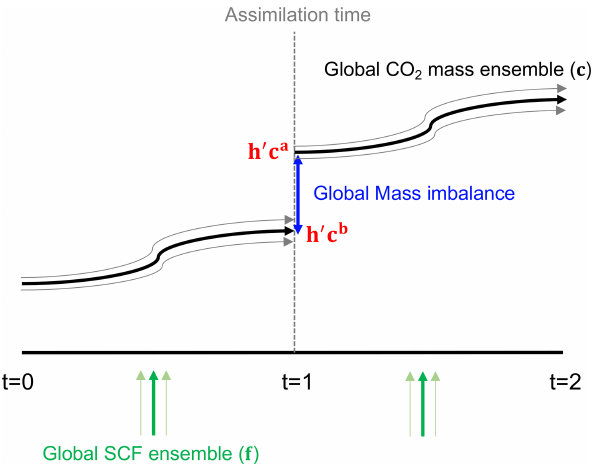
Figure 2. Schematic illustration of the mass imbalance